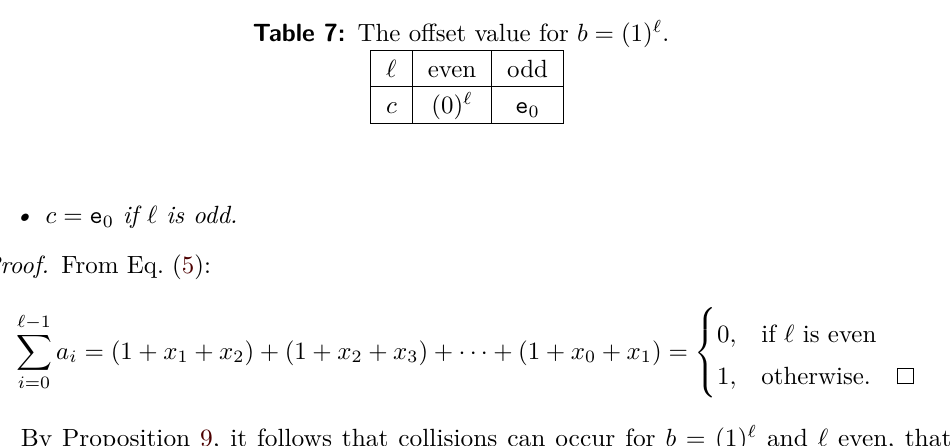
Table 7: The offset value for b = (1) ‘